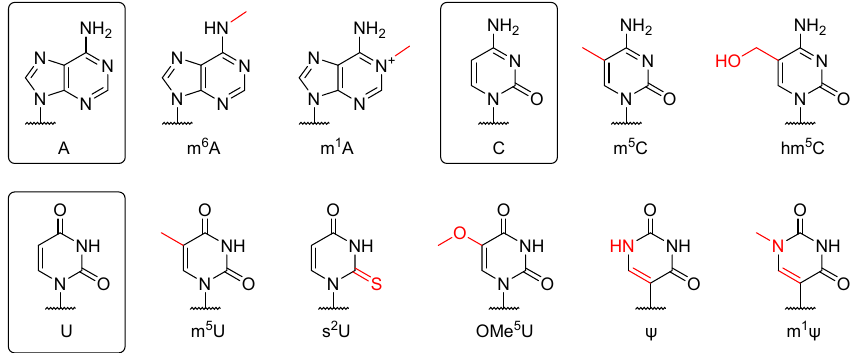
Figure 3. Chemical modifications on bases of IVT mRNAs.